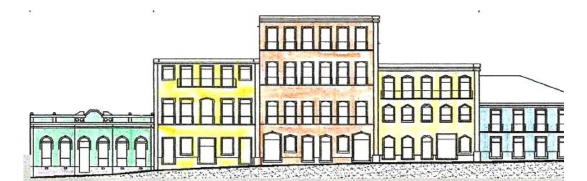
Figure 4. Schema representing the architectural set of S˜ao Lu´ıs, featuring blocks of buildings at varying heights. (Figueiredo,